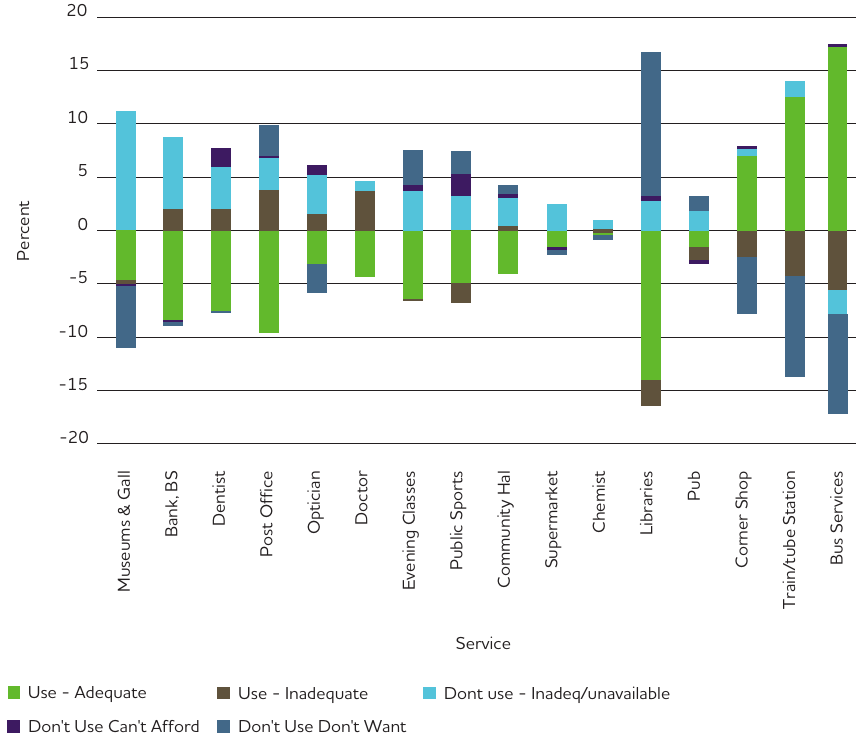
26 The cost of the cuts: the impact on local government and poorer communities